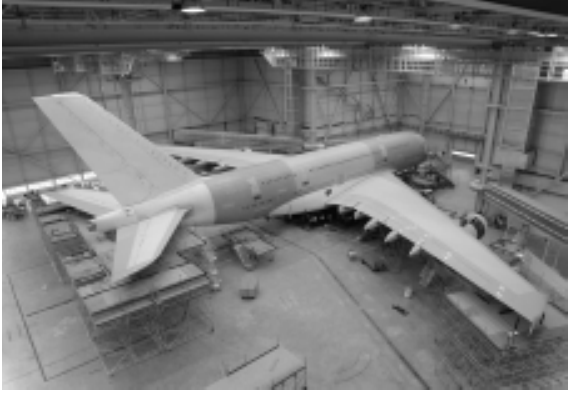
Fig. 5. Ground vibration tests on Airbus A380-800 (copyright Airbus